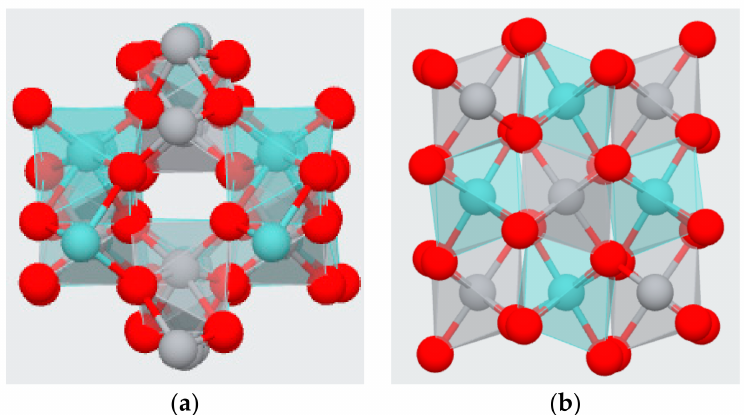
Figure 5. Schematic of two possible molecular structures ( a , b ) for ZrO 2 -TiO 2 (ZrTiO 4 ). (red, grey, or cyan ball indicates oxygen, titanium, or zirconium, respectively).